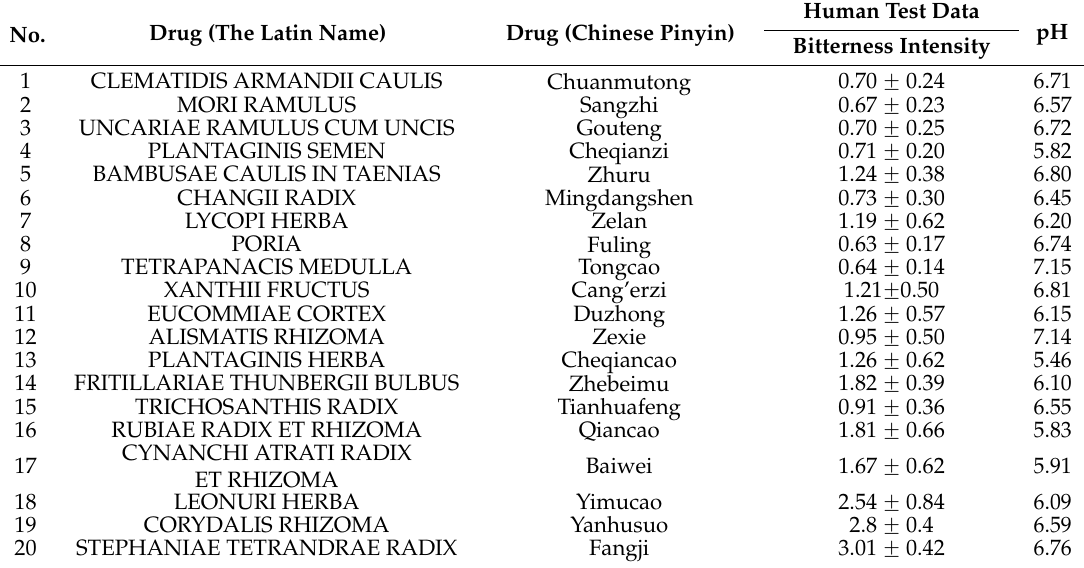
Table 2. The 35 samples and their degree of bitterness based on human